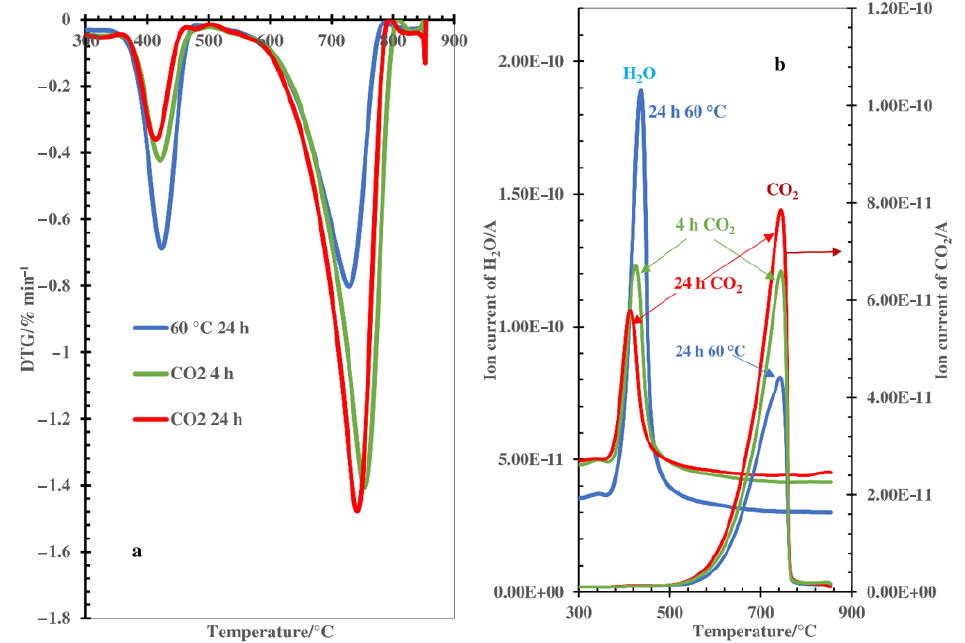
Figure 10. DTG curves ( a ) and emission profiles of H 2 O and CO 2 ( b ) for cyclone ash +10% clay granulated with transportation water (heating rate 10° min − 1 ).